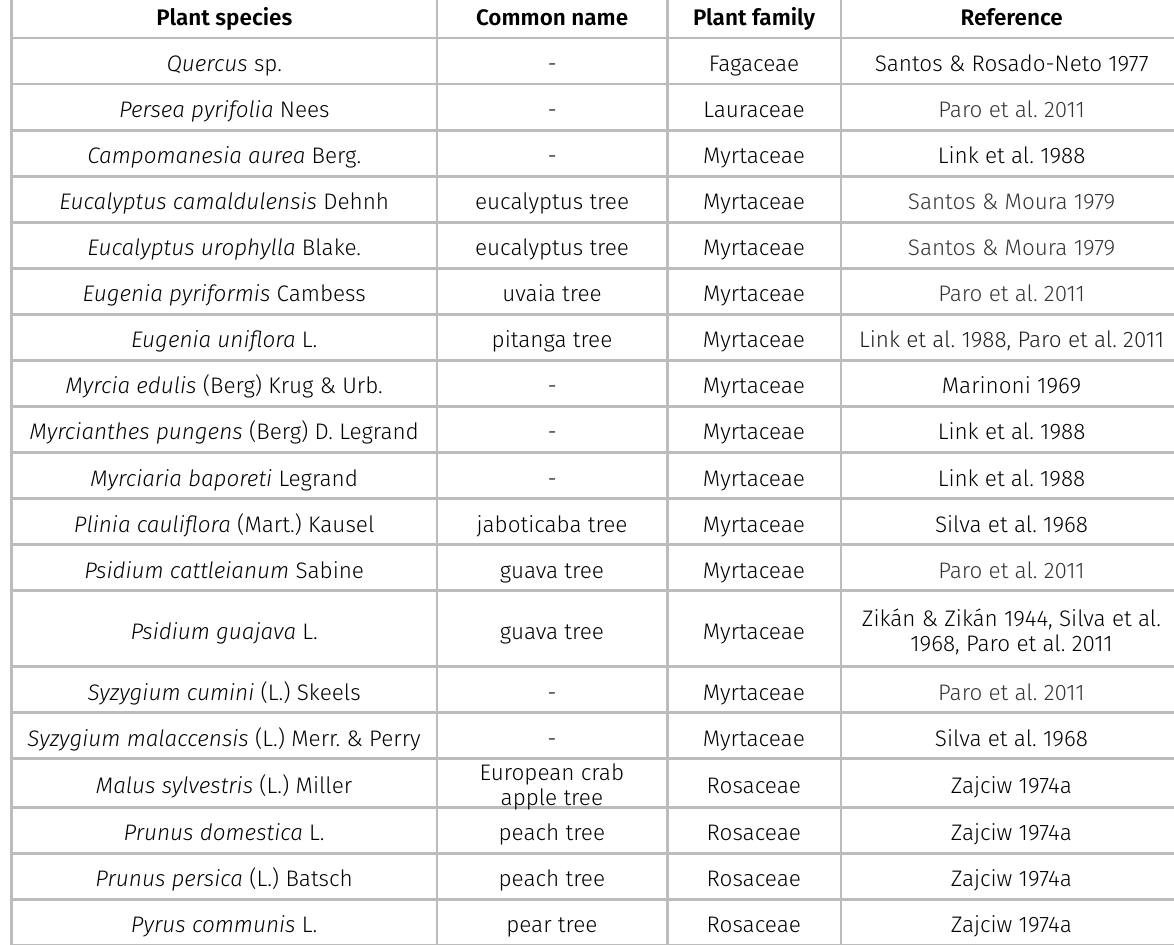
Table I. Botanical species used by P. griseocinctus as host